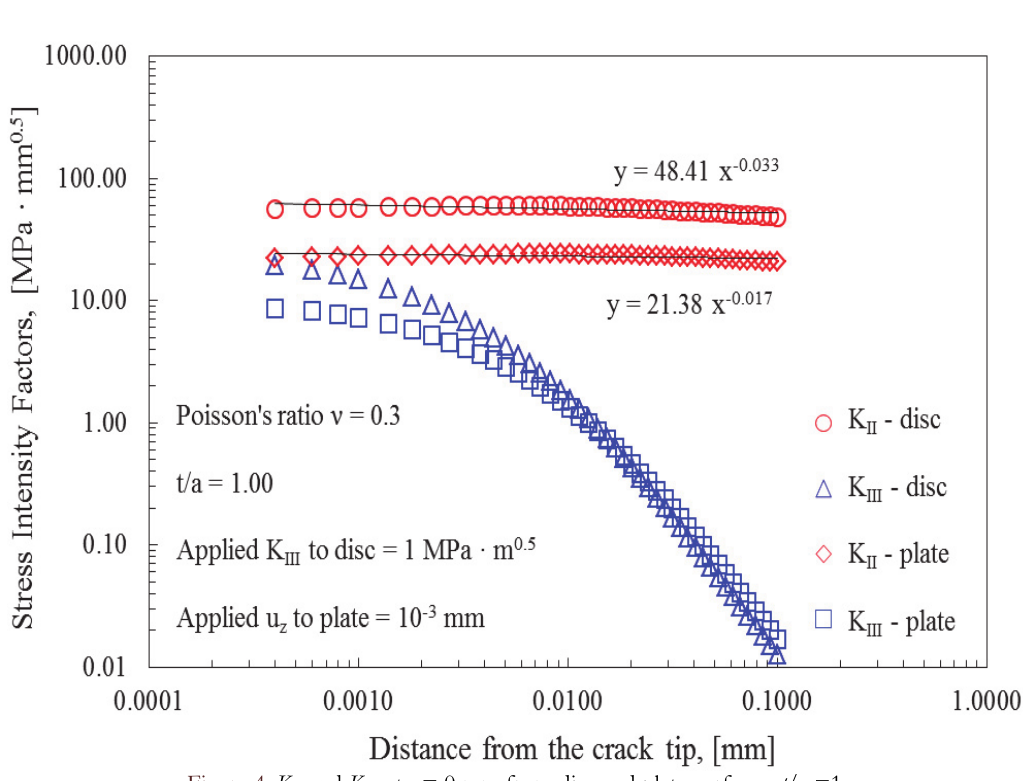
Figure 4: K II and K III at s = 0 mm from disc and plate surfaces, t/a